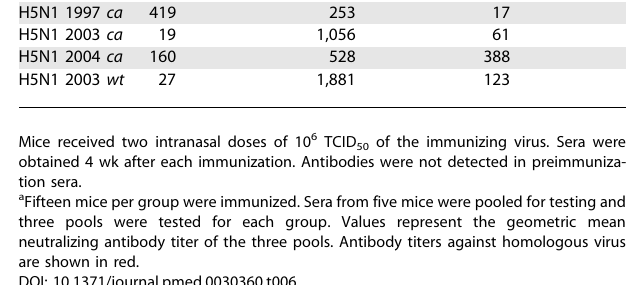
Table 7. Geometric Mean HAI Antibody Titers in Mice Immu- nized with One or Two Doses of the H5N1 2004 ca Influenza Virus Vaccine Regimen Geometric Mean HAI Titer against H5N1 2004 wt with Turkey (Horse) Erythrocytes